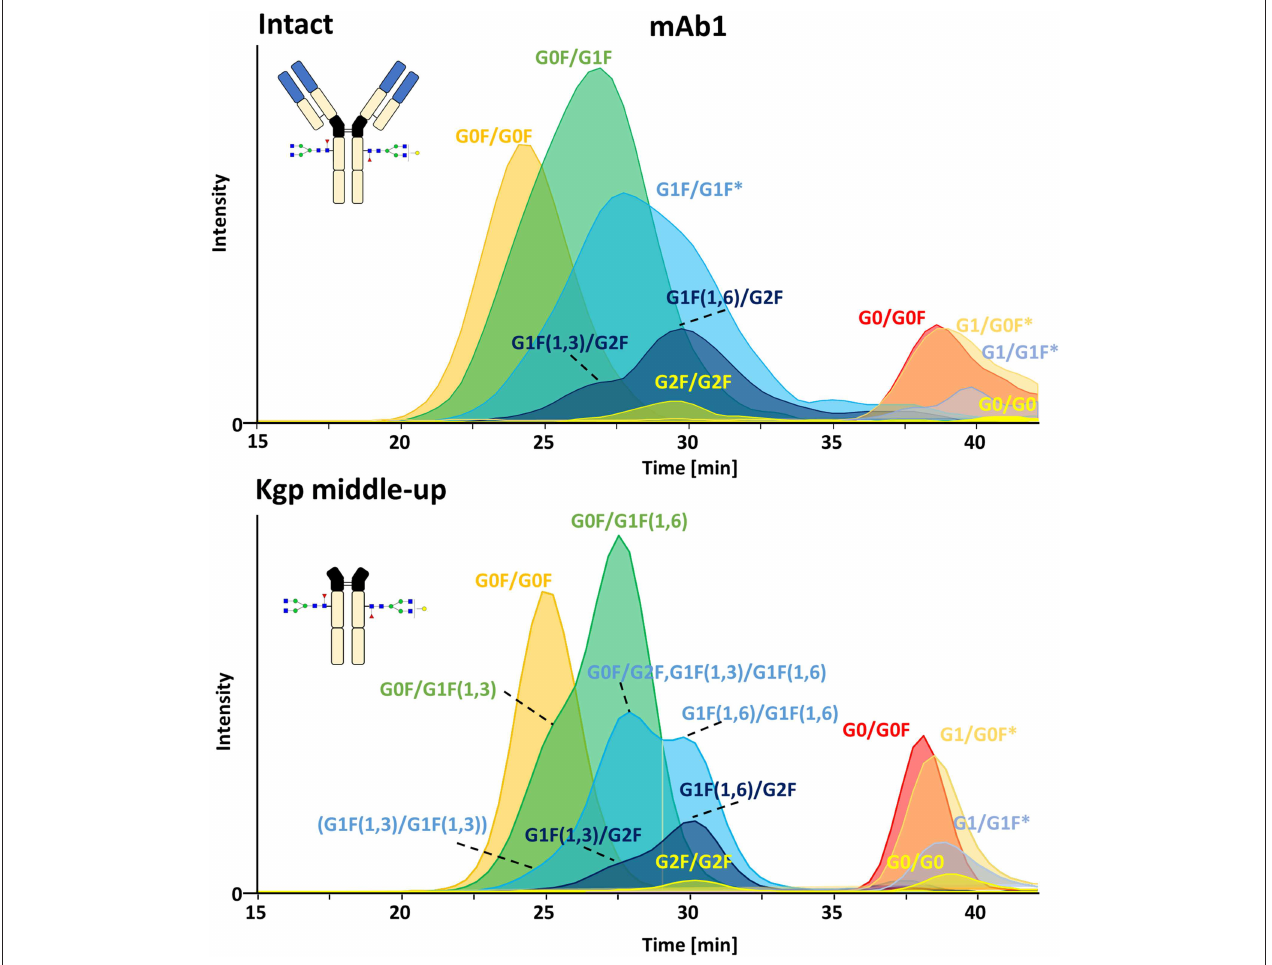
FIGURE 3 | Extracted ion chromatograms of major glycoforms assigned for Fc È RIIIa AC-MS of mAb1 on intact and Kgp middle-up level. *indicates additional isomers listed in Supplementary Table 2 .